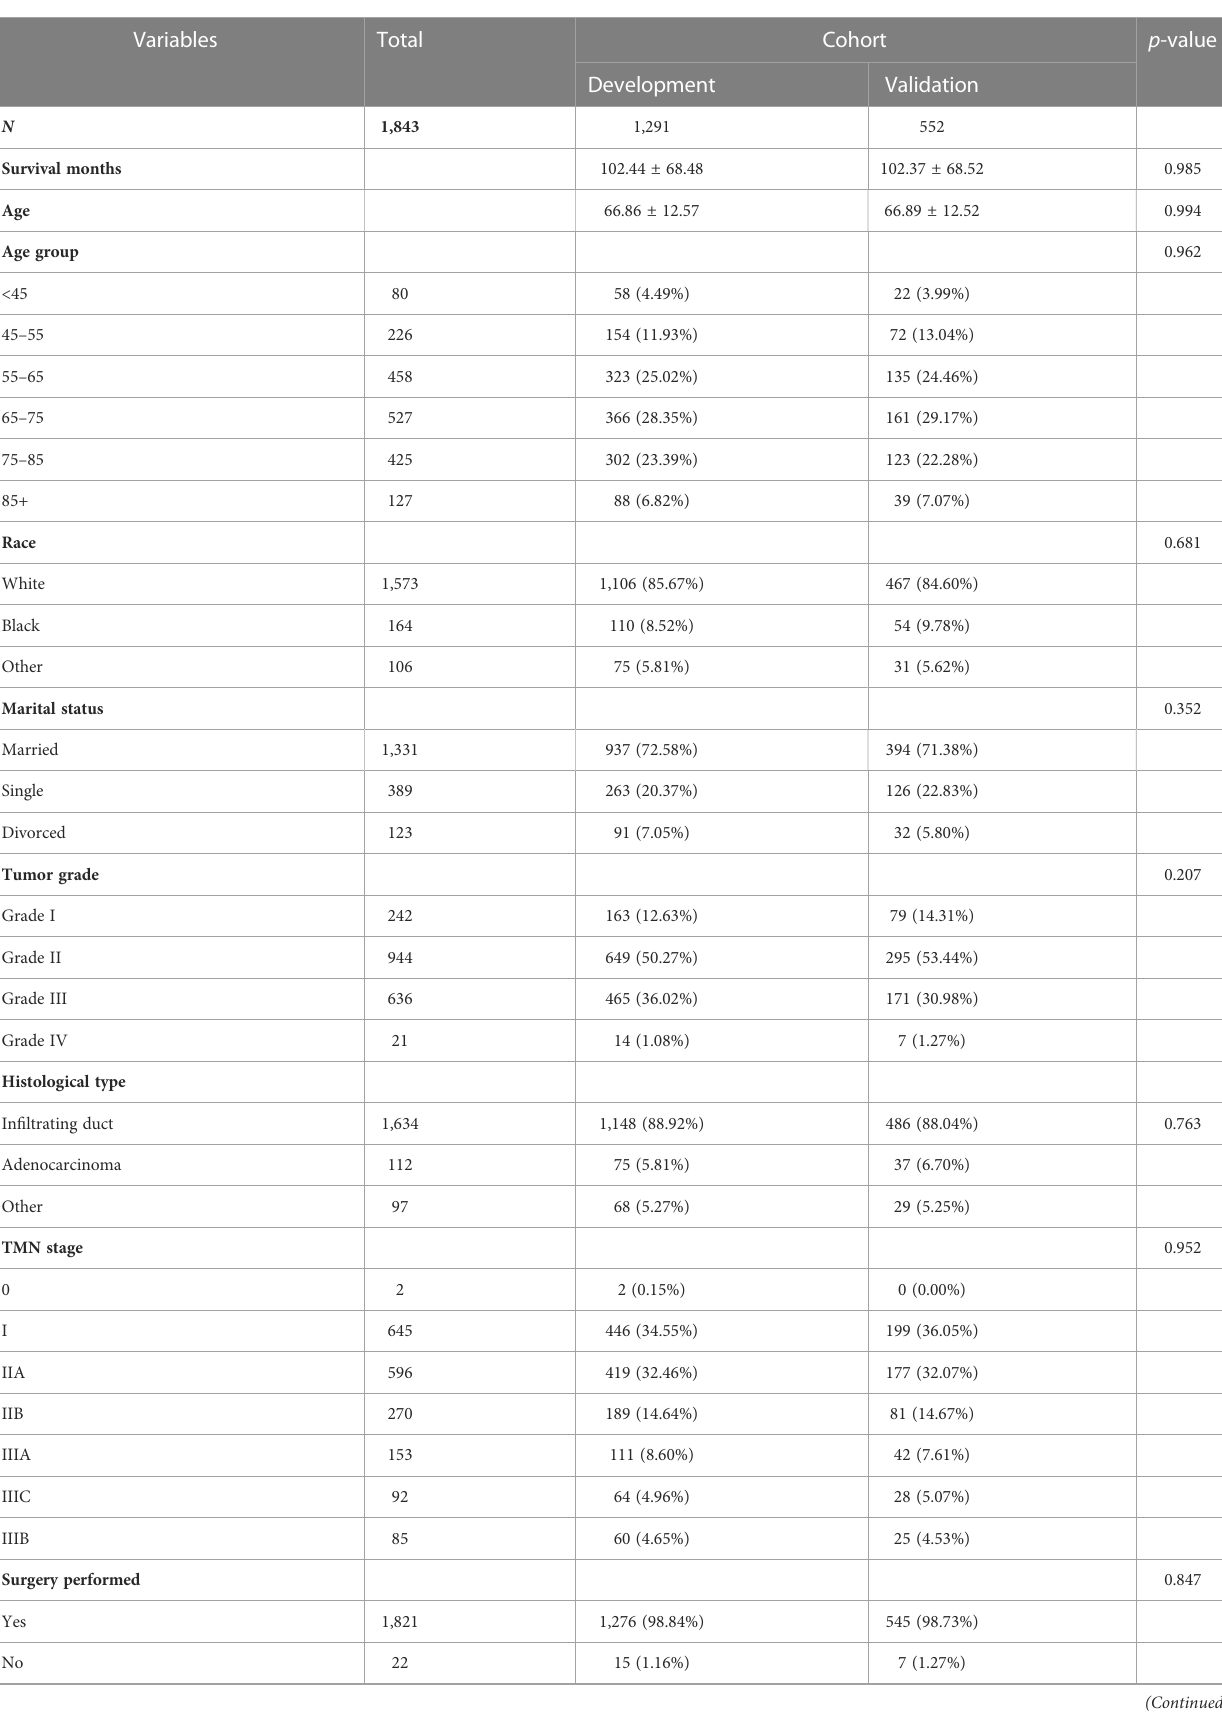
TABLE 1 Patient characteristics and clinicopathological